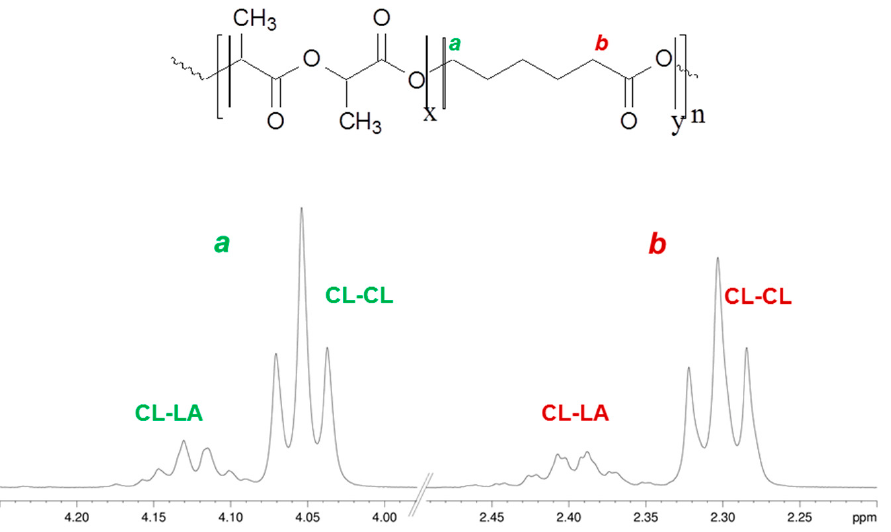
Figure 2. 1 H NMR spectrum of poly-(L-Lactide- co - ε -caprolactone) (CDCl 3 , 25 °C, 300 MHz) in the methylene regions.